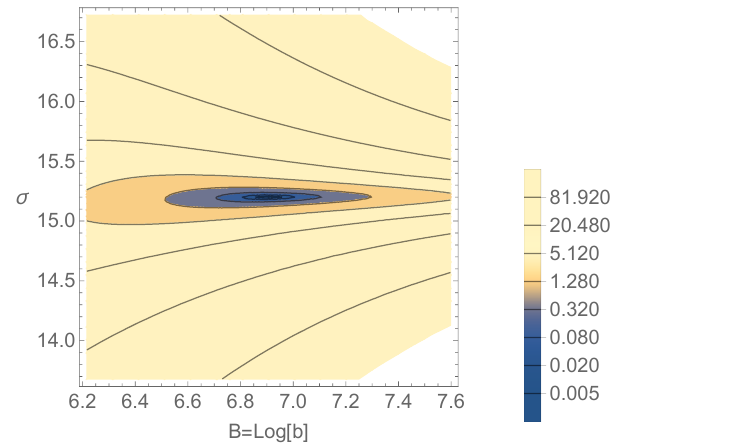
Figure 5. The moduli potential V mod ( b, σ ) with ( m, σ ∗ ) = (10 − 2 , 15 . 2) . The minimum is ( B, σ ) = (6 . 8 , 15 . 2) , and b = 1000 vac